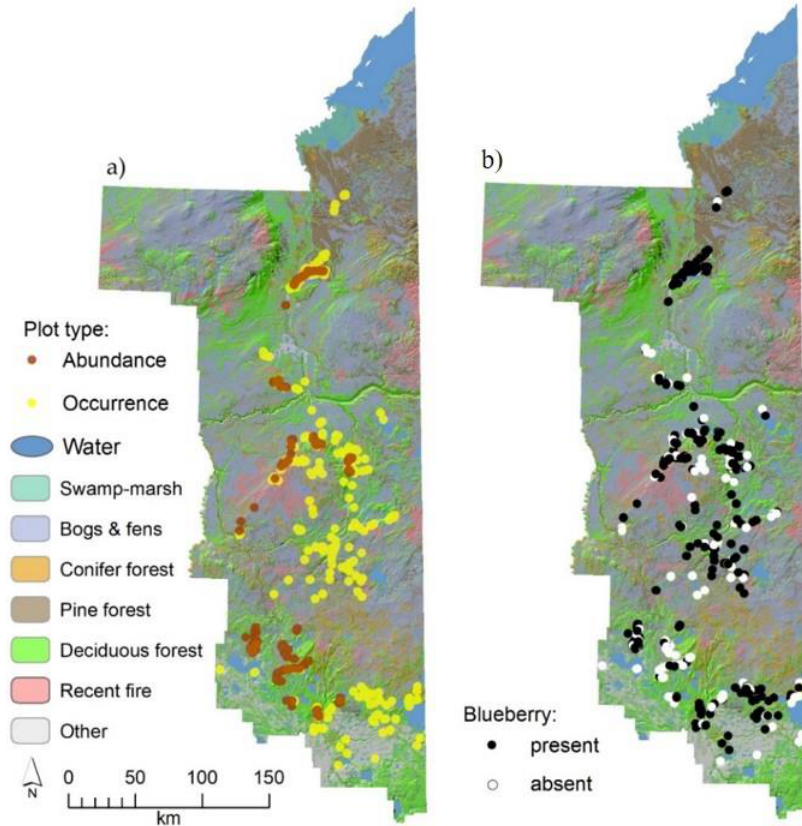
Figure A1. ( a ) Distribution of study plots by type of data collected with ‘occurrence’ plots ( n = 510) only assessing presence−absence, while abundance plots ( n = 335) assessed presence−absence, shrub abundance where present, and for a subset of plots ( n = 90) fruit production for velvet−leaf blueberry in northeast Alberta, Canada; and ( b ) the distribution (presence−absence) of velvet−leaf blueberry. Broad land cover types are provided in both maps based on the Ducks Unlimited Enhanced Wetland Classification. A DEM−derived hillshade model is used as a base layer in maps to emphasize the underlying terrain.